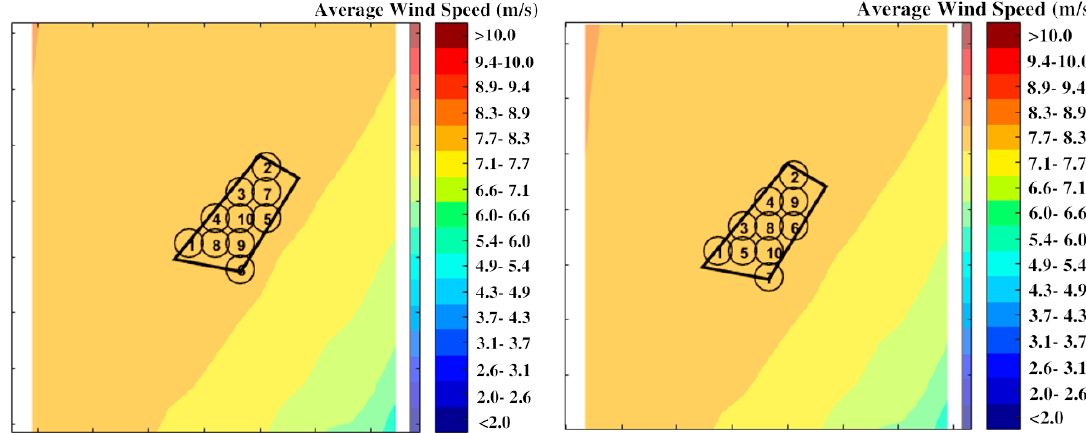
Figure 9. Wind resource map and optimized wind farm layout analyzed according to WindSim with MCP data obtained using data from MERRA location 2 and the floating LiDAR device ( left ) and the mast ( right ).